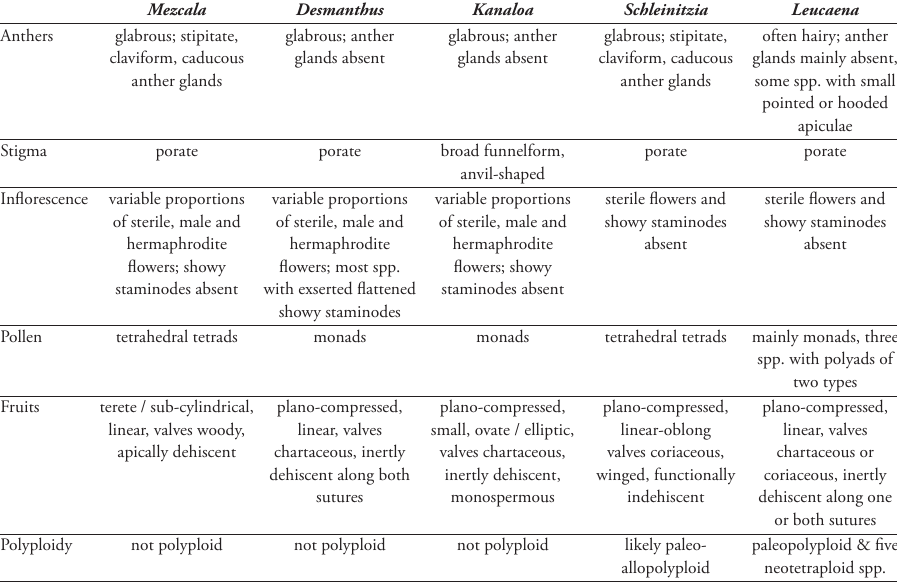
Table 1. Morphological differences among genera of the Leucaena